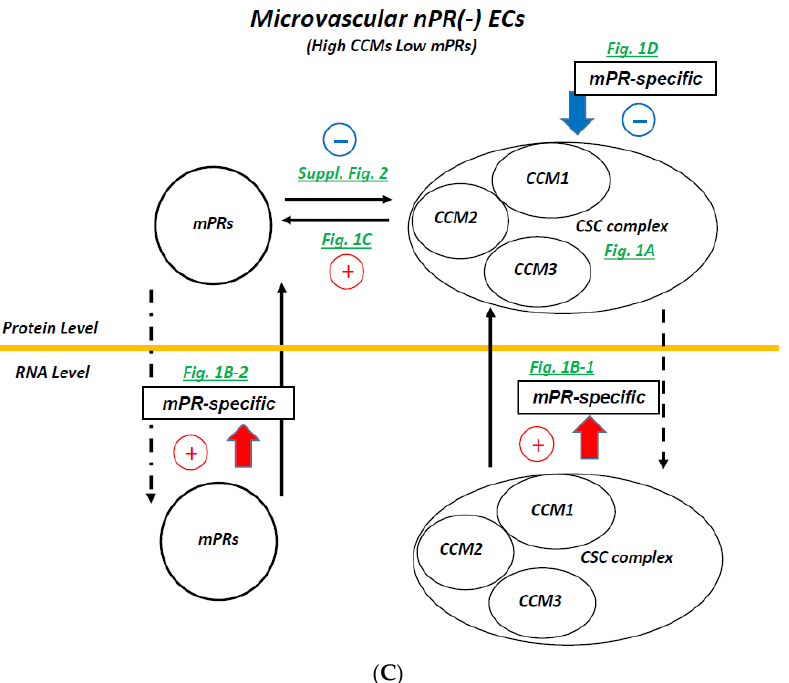
Figure 2. mPR-specific actions on nPR(+/ − ) ECs increases microvascular permeability in vitro. Two different EC lines, nPR(+) EAhy926 ECs, derived from HUVECs, and nPR( − ) RBMVECs, were used to measure in vitro permeability with the passage of FITC-conjugated dextran under vehicle and various steroid treatments. ( A ) Impact of sex-steroid-induced mPR-specific actions on the permeability of both nPR(+/ − ) ECs. Both nPR(+/ − ) ECs were under sex steroid treatments (PRG (20 µ M), MIF (20 µ M), and PRG + MIF, (20 µ M each)) plated on either uncoated (top panels) or collagen-I coated wells (bottom panels). Although increased levels of permeability were initially observed in both ECs (on Collagen-I coated wells, bottom panels), the permeability of nPR(+) EAhy926 ECs was back to normal after 12 h (bottom right panel), while the permeability was continuously enhanced among all sex hormone treatments for RBMVECs (bottom left panel) on Collagen-I coated wells. Interestingly, permeability remained continuously enhanced among all sex hormone treatments for RBMVECs, when cultured in the absence of collagen-I (upper left panel), while the permeability of nPR(+) EAhy926 ECs did not return to normal until after 48 h (upper right panel), suggesting crosstalk between integrin and PRG-receptors-mediated signaling cascades in nPR(+) EAhy926 ECs, but not in nPR( − ) RBMVECs. Four treatments are Vehicle, PRG, MIF, and PRG + MIF sequen- tially. ( B ) Impact of neurosteroids-induced mPR-specific actions on the permeability of both nPR(+/ − ) ECs. Both nPR(+/ − ) ECs treated with two common neurosteroids synthesized from PRG (or PRG metabo- lites), Allopregnanolone (3a-hydroxy-5a-pregnan-20-one, ALLO, 20 µ M) and Pregnanolone (3a- hydroxy-5b-pregnan-20-one, P5, 20 µ M), were plated on collagen-I coated wells, and the EC per- meability was continuously monitored and measured as aforementioned. ( C ). The summarized feedback regulatory mechanism within the CmP signaling network under mPR-specific PRG actions for nPR( − ) ECs. Yellow line separates transcriptional and translational levels. The + symbols repre- sent enhancement, and symbols represent inhibition of the expression of targeted genes/proteins. Red-colored symbols/lines represent positive effects of mPR-specific PRG treatment (PRG + MIF), and blue-colored symbols/lines represent negative effects of treatment. Dark-green-colored letters indicate the direct supporting data generated from this work. Arrow indicates effect direction, solid line is the direct impact, and dotted line is indirect effects. The fluorescence intensity of FITC-dextran was measured using a 96-multiwell fluorescent plate reader. In all bar plots, *, **, and *** above any bar graph indicate p ≤ 0.05, 0.01, and 0.001, respectively, using two-way ANOVA with Holm–Sidak’s multiple comparison